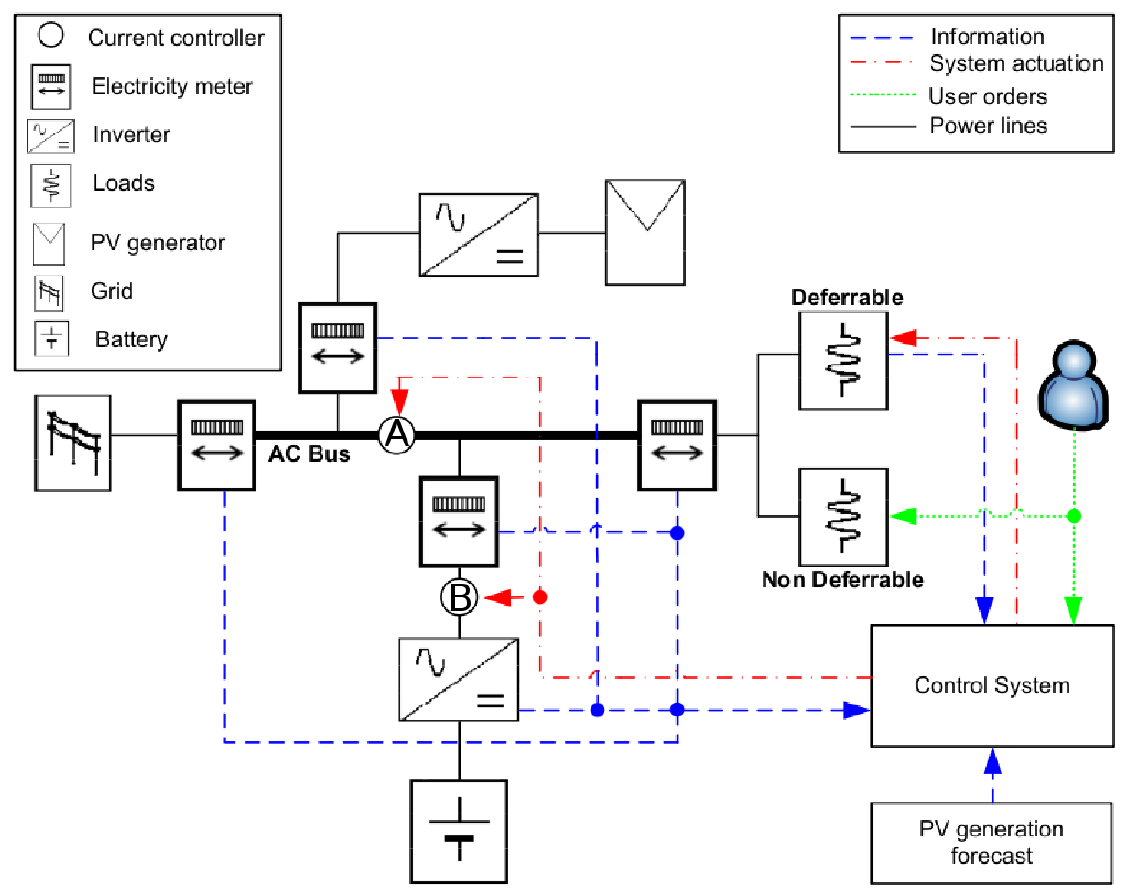
Figure 2. Depiction of the ADSM System